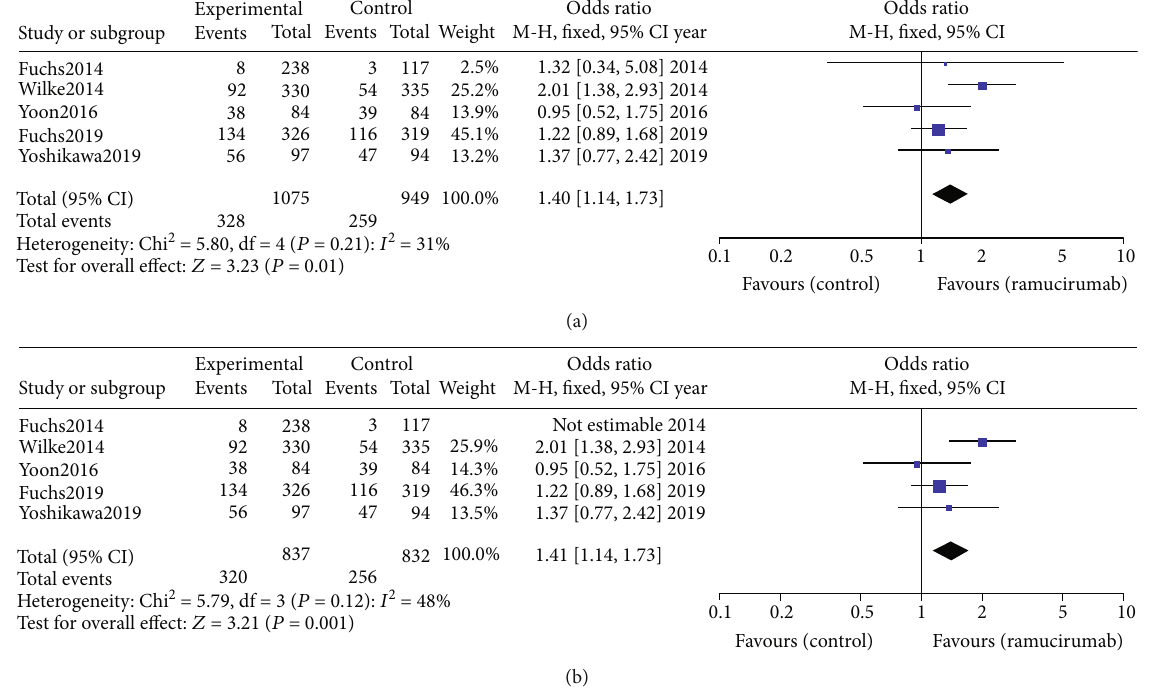
Figure 4: (a) Pooled analysis of objective response rate (ORR) comparing the application of ramucirumab (RAM) alone or plus chemotherapy with the control (placebo or chemotherapy). (b) Pooled analysis of ORR comparing the application of RAM alone or plus chemotherapy with chemotherapy.